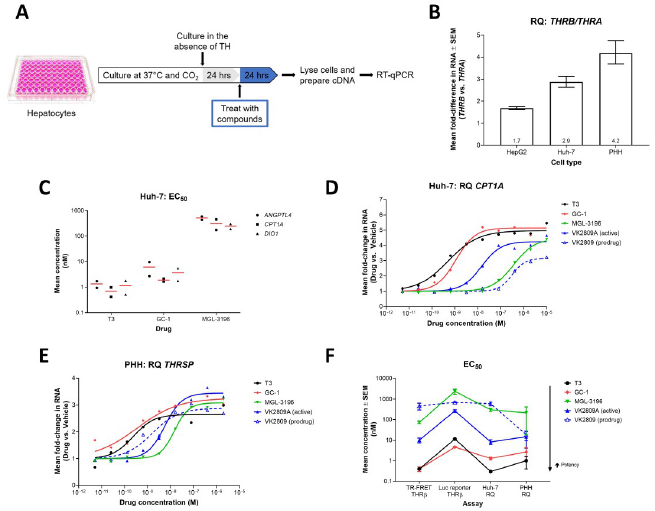
Fig 2. Differential gene expression in Huh-7 cells and PHH resulting from treatment with THR agonists. (A) Illustration of the in vitro , hepatic cell-based differential gene expression assay design. (B) THRB and THRA RNA levels were quantified by RT-qPCR in HepG2 (n = 3), Huh-7, (n = 3), and PHH (n = 5) cells. Mean RQ values ± SEM are reported with means annotated within the bars. (C) Huh-7 cells were treated with increasing doses of T3 (n = 2), GC-1 (n = 2), or MGL-3196 (n = 2) for 24 hrs. ANGPLT4 , CPT1A , and DIO1 RNA levels were quantified by RT-qPCR and dose-response curves were generated for each gene-compound combination. Mean EC 50 values (red bar) and individual replicate EC 50 values (black symbols) are reported. (D) Huh-7 cells were treated with increasing doses of T3 (black), GC-1 (red), MGL-3196 (green), VK2809A (solid blue), or VK2809 (dashed blue) for 24 hrs. CPT1A RNA levels were quantified by RT-qPCR. Representative mean RQ values at each compound concentration and fitted dose- response curves are reported. (E) PHH were treated with increasing doses of T3 (black), GC-1 (red), MGL-3196 (green), VK2809A (solid blue), or VK2809 (dashed blue) for 24 hrs. THRSP RNA levels were quantified by RT-qPCR. Representative mean RQ values at each compound concentration and fitted dose-response curves are reported. (F) EC 50 values for every test compound were calculated from dose-response curves generated from the TR-FRET THR β , luciferase (Luc) reporter THR β , Huh-7 differential gene expression (RQ), and PHH RQ assays (data reported in Tables 1 and 2). Mean EC 50 values ± SEM are